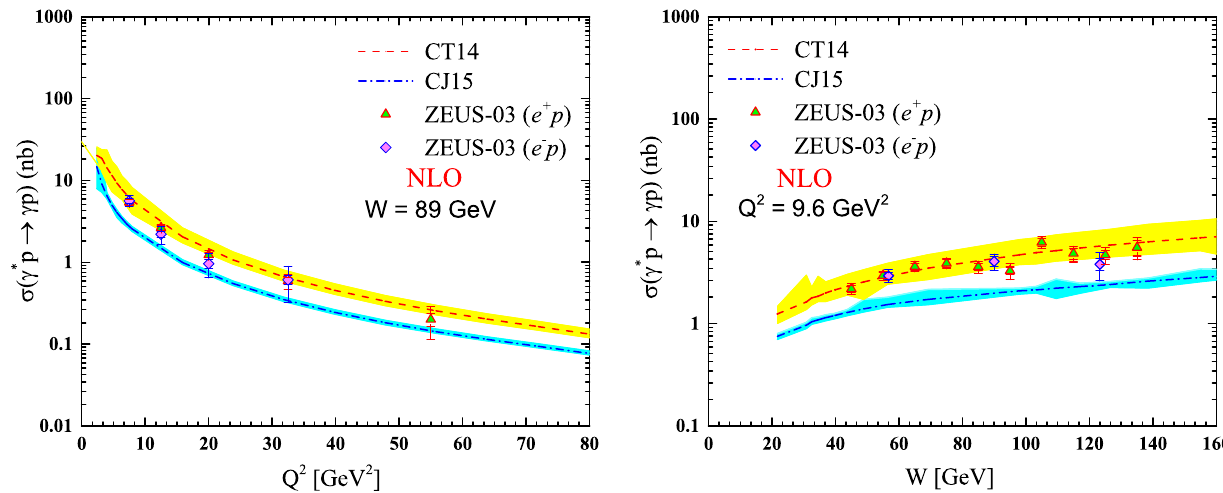
Fig. 8 The DVCS γ ∗ p → γ p cross section as a function of Q 2 (left) and W (right). Our NLO pQCD results are compared to the 2003 ZEUS data [80]; see for details Fig. 4. The inner error bars represent the statistical errors, and the outer error bars the statistical and systematic errors added in quadrature